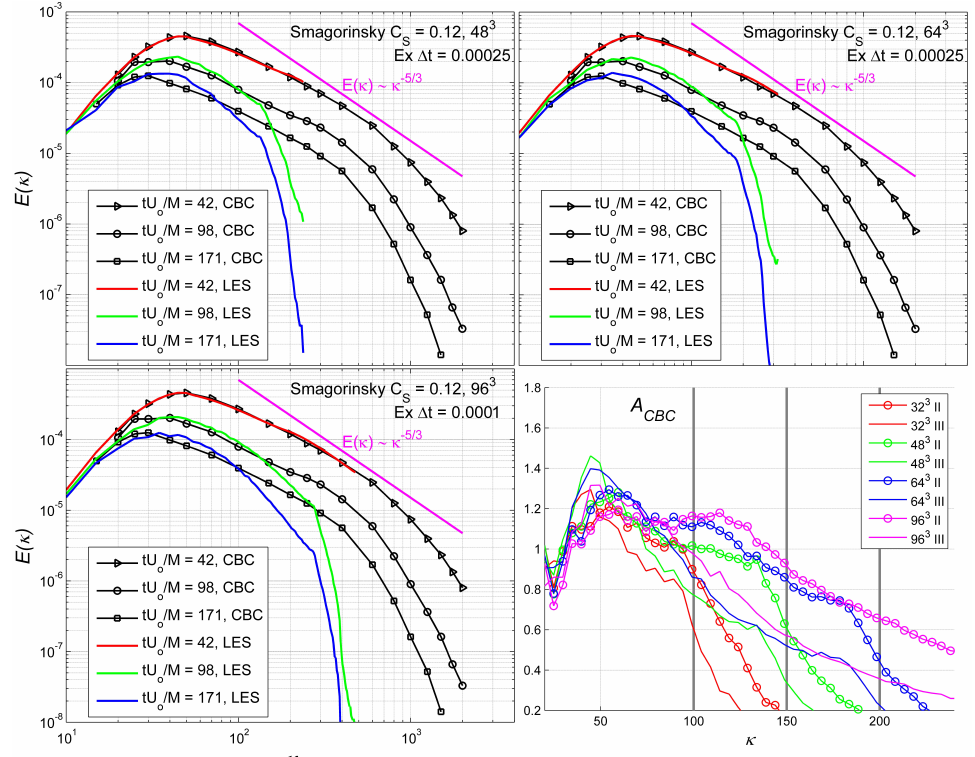
Figure 7. Changes in the energy spectra for C S = 0.12 with the ECNS on 48 3 , 64 3 and 96 3 grids. The ( bottom-right ) plot shows A CBC at different grid